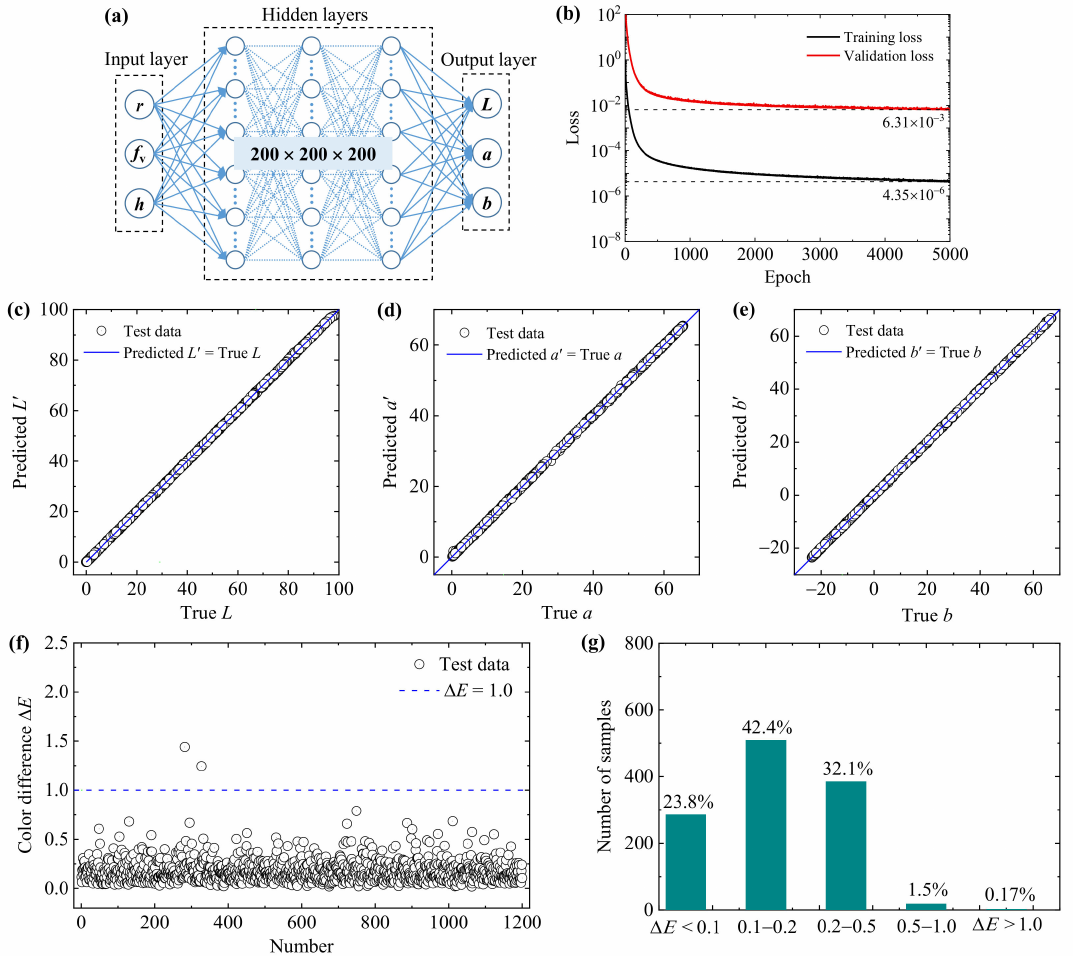
Figure 5. The forward neural network for predicting the colors of gold nanoparticle systems. ( a ) Structure of the forward neural network. ( b ) The loss functions of the training and validation sets. ( c – e ) Scatter plot of the true colors ( L , a , b ) and predicted colors ( L (cid:48) , a (cid:48) , b (cid:48) ) for the 1200 groups of test data. ( f ) The color differences ∆ E between the predicted colors and true colors. ( g ) Statistical distributions of the testing results divided by different ranges of color